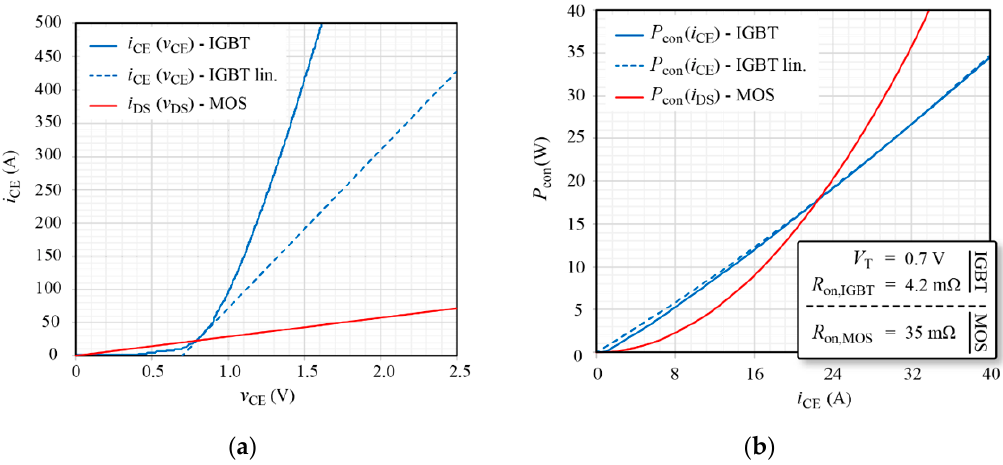
Figure 9. ( a ) V / I and ( b ) I / P characteristic of a Si–IGBT to extract forward voltage and ON–resistance